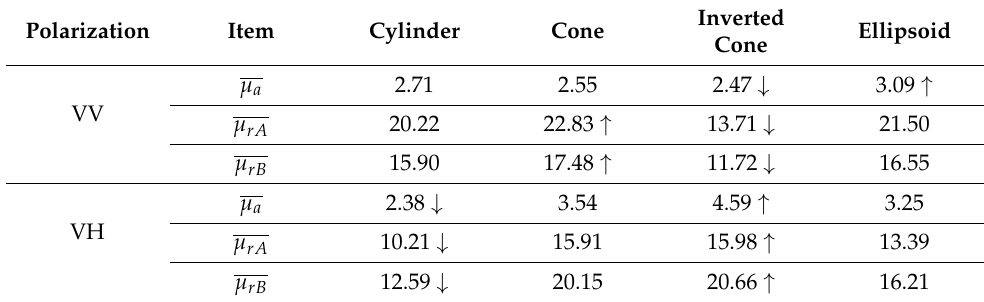
Table 8. µ a and µ r of the FEKO simulation results for the same crown shapes between canopies A and